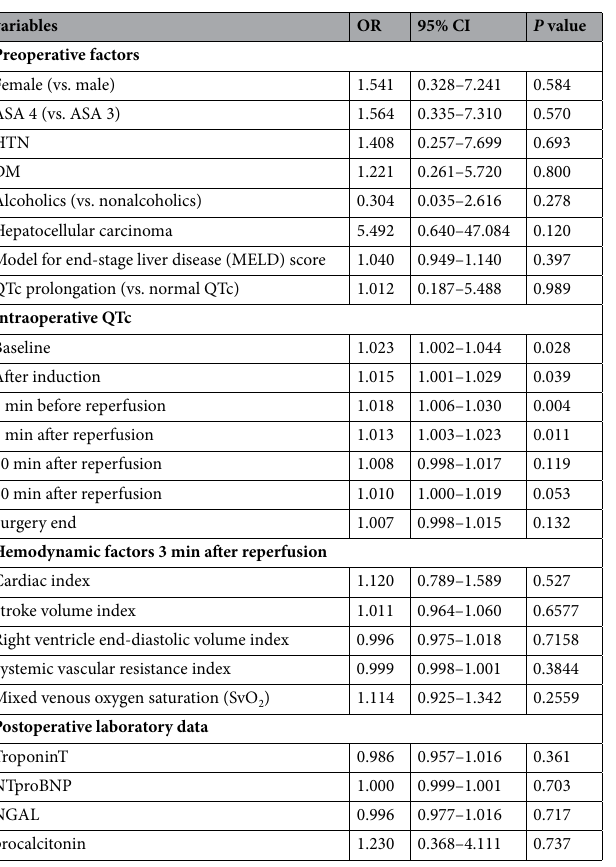
Table 5. Univariable logistic regression analysis of factors associated with postoperative cardiac complications. CI, confidence interval; OR, odds ratio; NGAL, neutrophil gelatinase-associated lipocalin; NTproBNP, N-terminal probrain natriuretic